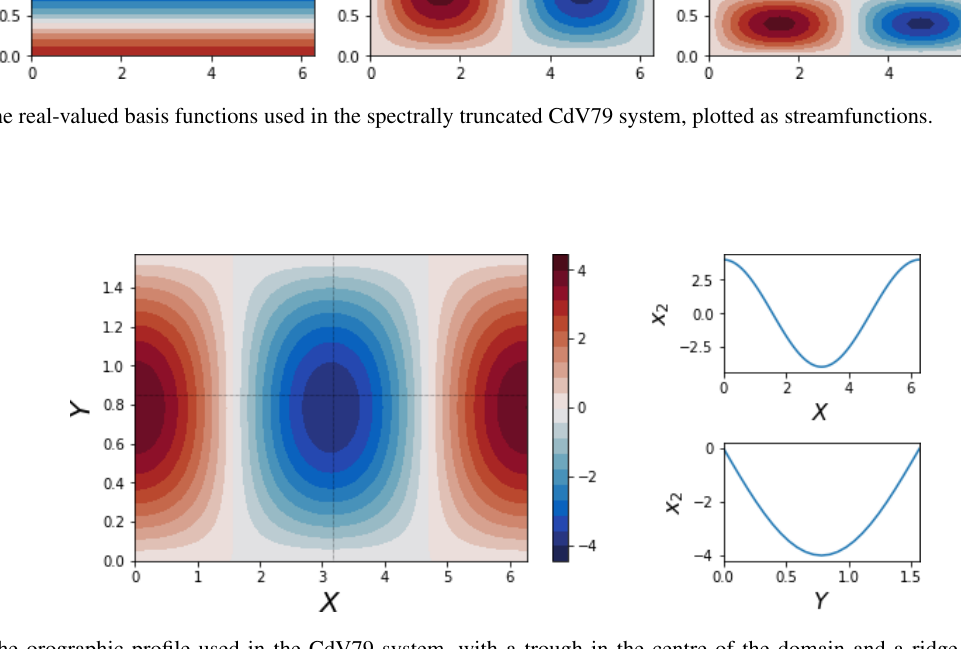
Figure A2. The orographic profile used in the CdV79 system, with a trough in the centre of the domain and a ridge over the periodic boundary. Sub-panels show cross sections across the domain, following the dotted black lines.